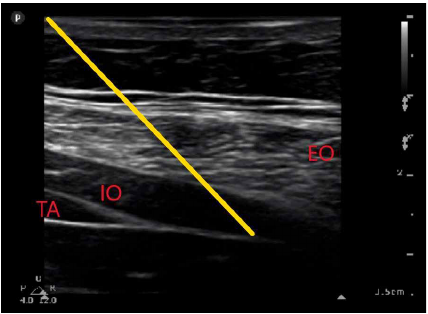
Figure 3: Ultrasound image obtained to place nerve catheters. EO = external oblique muscle. IO = internal oblique muscle. TA = transversus abdominis muscle. Yellow line depicts trajectory of needle into posterior aponeurosis of transversus abdominis